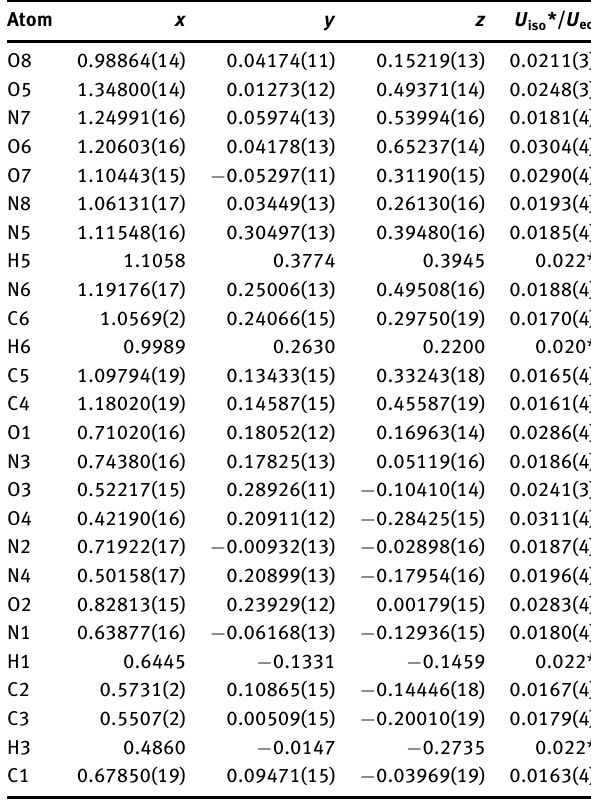
Table 2: Fractional atomic coordinates and isotropic or equivalent isotropic displacement parameters (Å 2